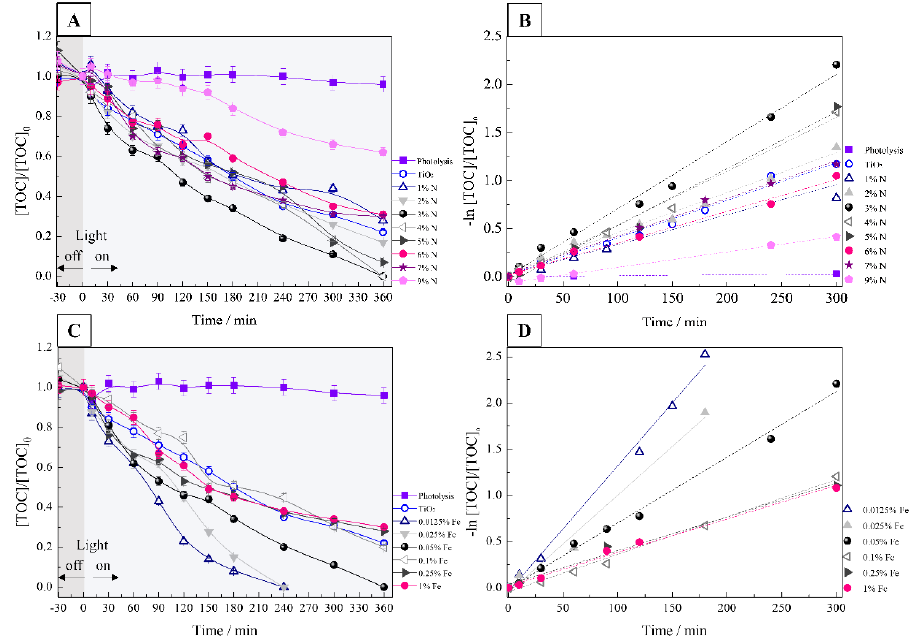
Figure 9. ( A , C ) Normalized 2,4-DMA mineralization curves obtained from the PC treatment of 350 mL of a solution of 0.1 mmol L − 1 of 2,4-DMA with 175 mg of photocatalyst, irradiated by a UVA lamp of 18 W ( B , D ) pseudo-first-order kinetics for PC treatment. Table 4. Removal percentage mineralization and pseudo-first-order constant.